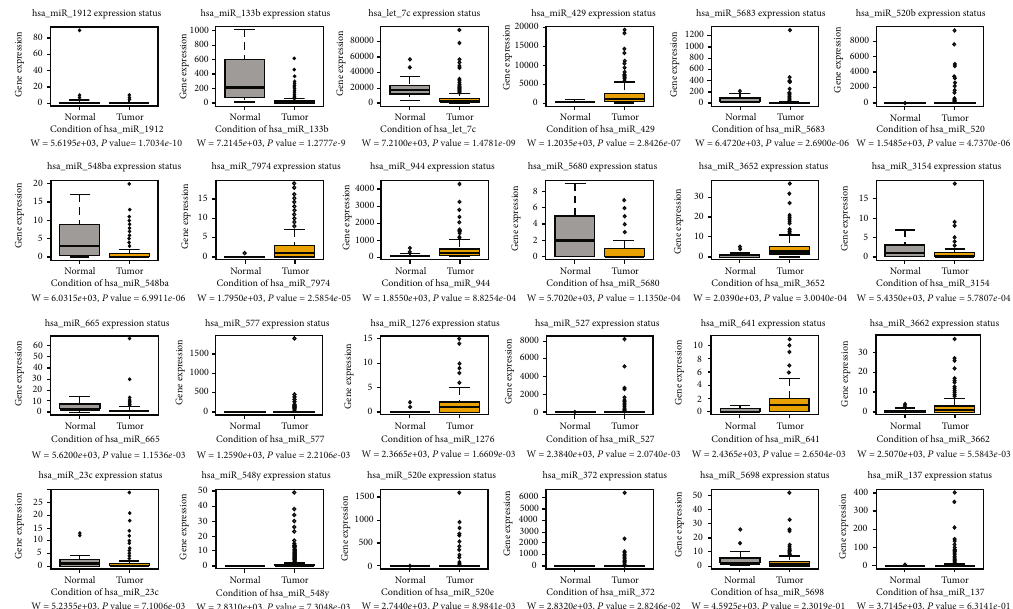
Figure 6: Expression pro fi les of the 24 hub miRNAs between bladder cancer and normal groups. The signi fi cant di ff erence was under the condition of P value <